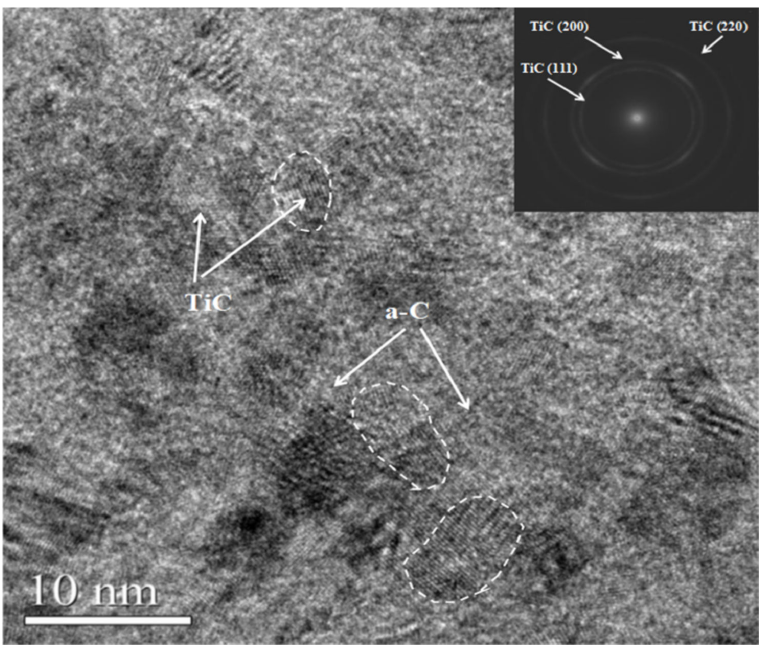
Figure 2. TEM image and SAED pattern of the coating at − 200 V.